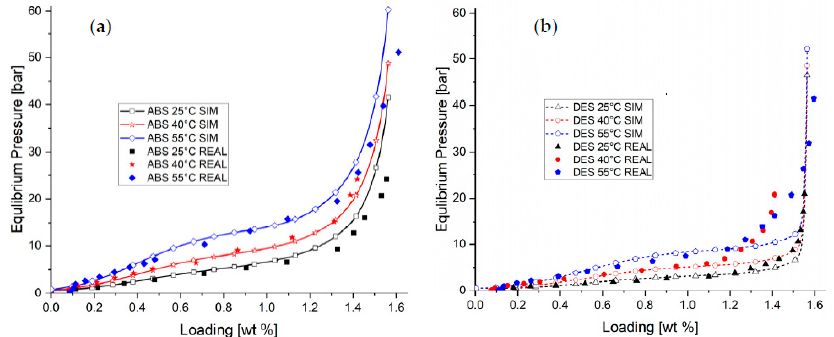
Figure 3. Comparison between the experimental (symbols) and fitted PCIs for TiFeMn hydride forming alloy (lines). Solid lines illustrate fits for the absorption ( a ) and dotted lines, desorption ( b ).